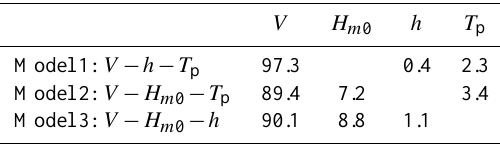
Table 1. Percentage of the contribution of single variables for the 3 best-performing models presented in Fig.